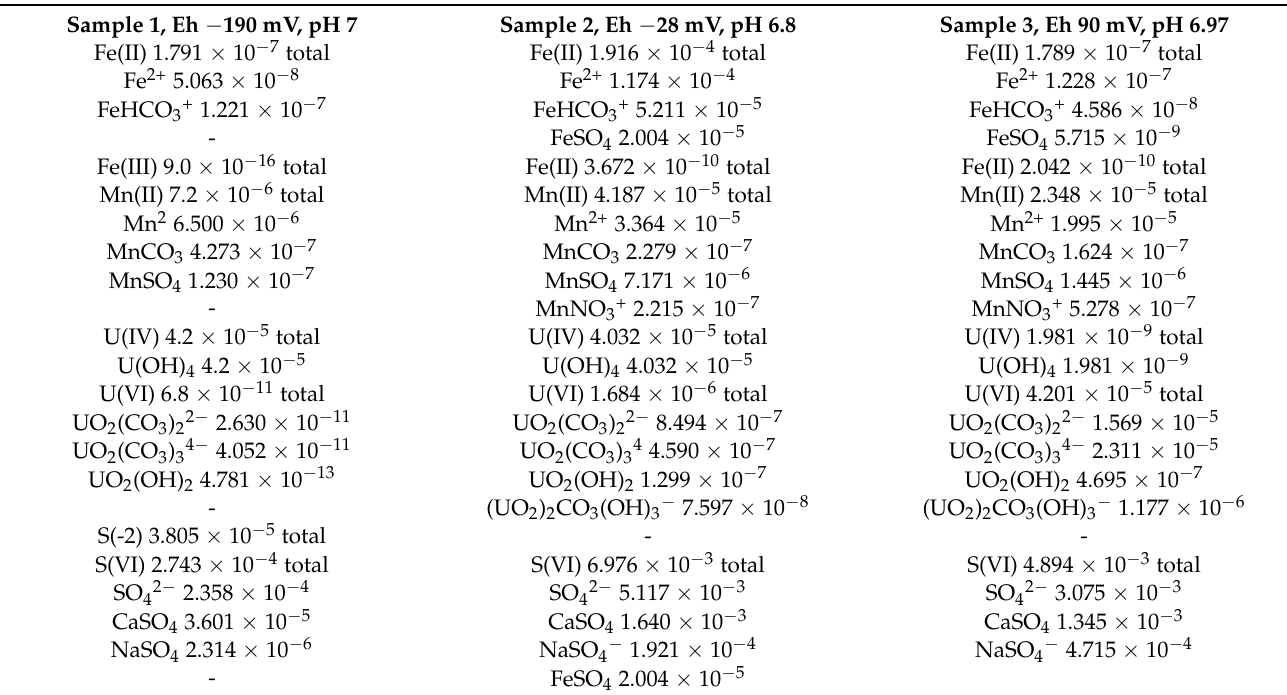
Figure 2. The number of cells of different functional groups in the formation fluid samples, cells/mL. Table 2. Main species and molality in water samples under different redox conditions (PHREEQC